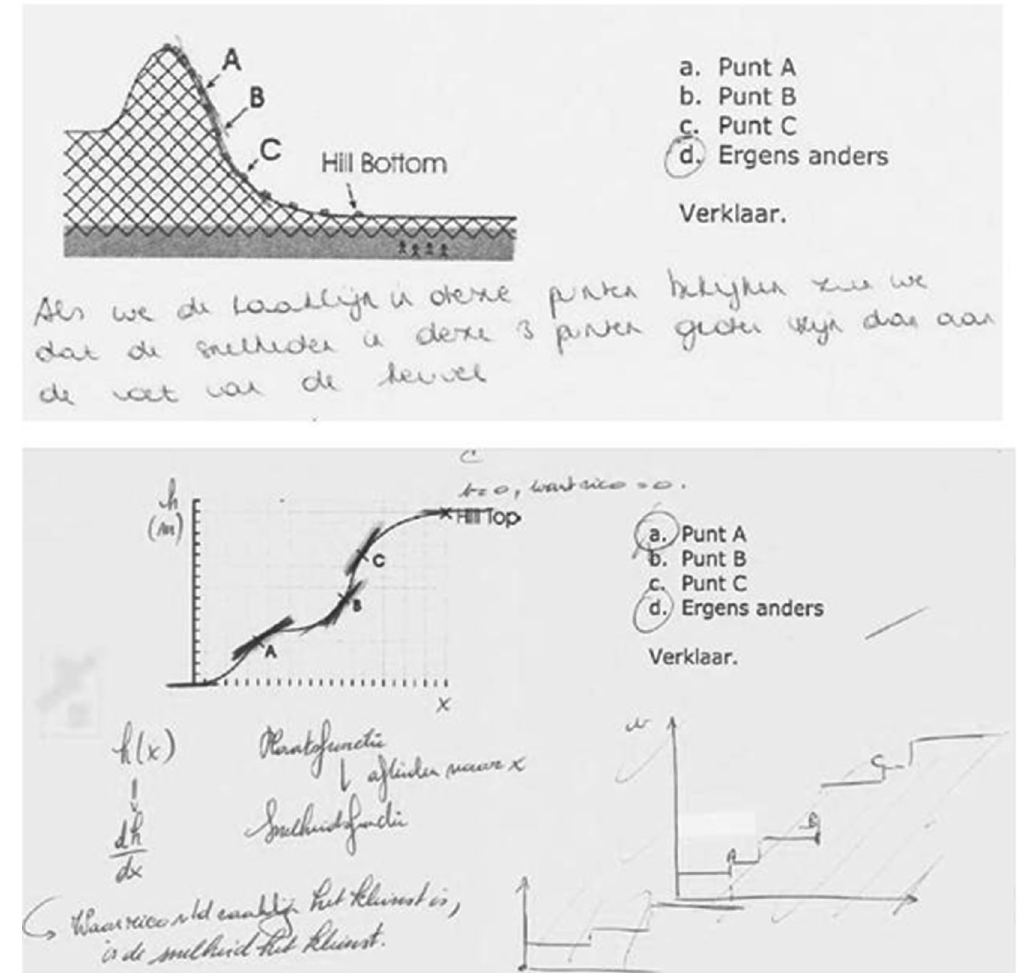
FIG. 2. Examples of student answers confusing the slope of the picture or graph with the